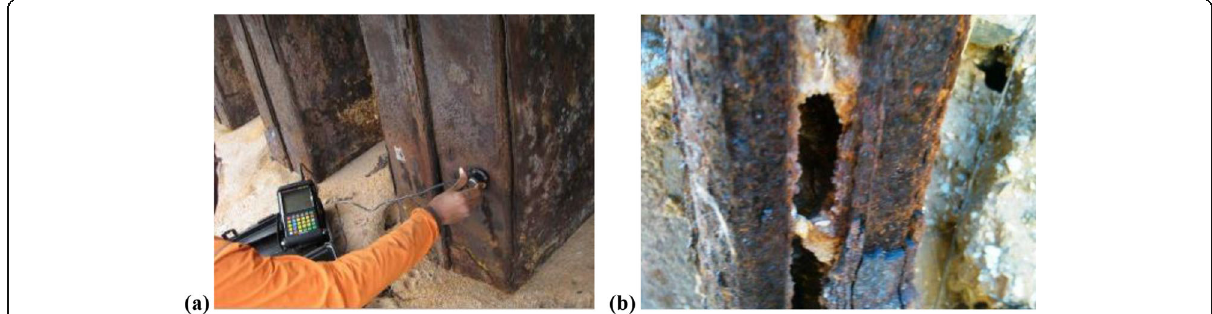
Fig. 3 Typical examples of severe corrosion damage on steel sheetpile seawalls [71]: a Section thickness testing; b Perforation at